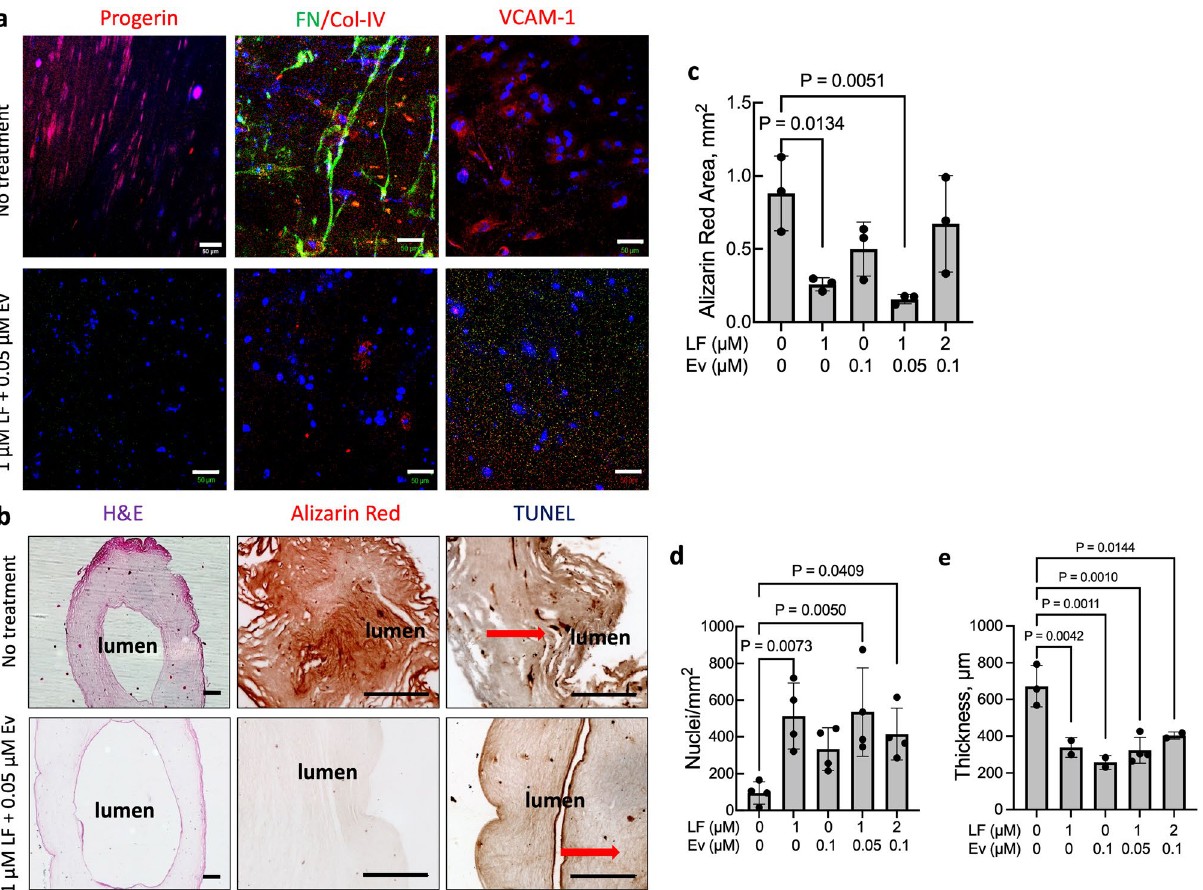
Figure 6. Lonafarnib and Everolimus treatment mitigates HGPS TEBV pathology. Representative immunofluorescence images of ( a ) progerin, fibronectin (FN), collagen IV (Col-IV), vascular cell adhesion molecule-1 (VCAM-1), and ( b ) H&E staining, alizarin red staining, and TUNEL staining in HGPS 167 CL2 TEBVs matured for 3 weeks then treated with 1 µM Lonafarnib (LF) + 0.05 µM Everolimus (Ev) for 1 week. Scale bar 50 µm for progerin, FN/Col-IV, and VCAM-1, and 200 µm for H&E, alizarin red, and TUNEL. ( c ) Quantification of alizarin red-positive area in untreated and treated HGPS 167 Cl2 TEBVs. ( d ) Nuclei density and ( e ) TEBV thickness in untreated and treated HGPS 167 CL2 TEBVs. Data presented as mean ± SD. N = 3 TEBVs per group for alizarin red and 4 TEBVs per group for cell density. *p < 0.05, **p < 0.01 compared with untreated case. Representative images for the 1 µM Lonafarnib treatment, 0.1 µM Everolimus treatment, and 2 µM Lonafarnib + 0.1 µM Everolimus treatment conditions are shown in Figs. S12 and